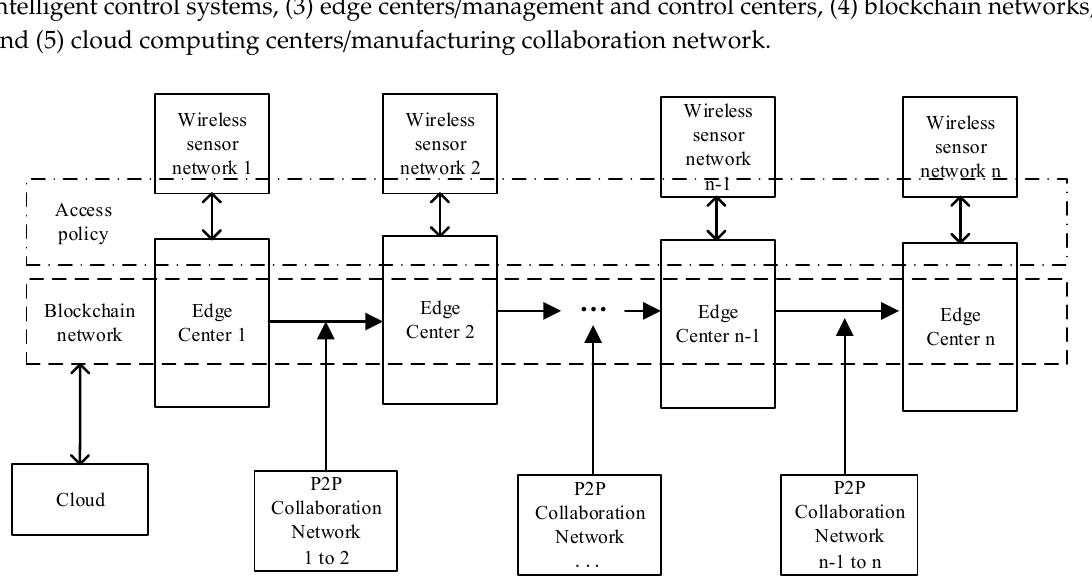
Figure 3. Identity management and access control model under edge computing.